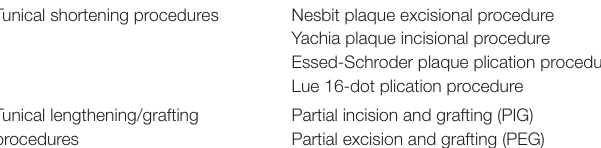
TABLE 1 | Options of surgical treatment. Tunical shortening